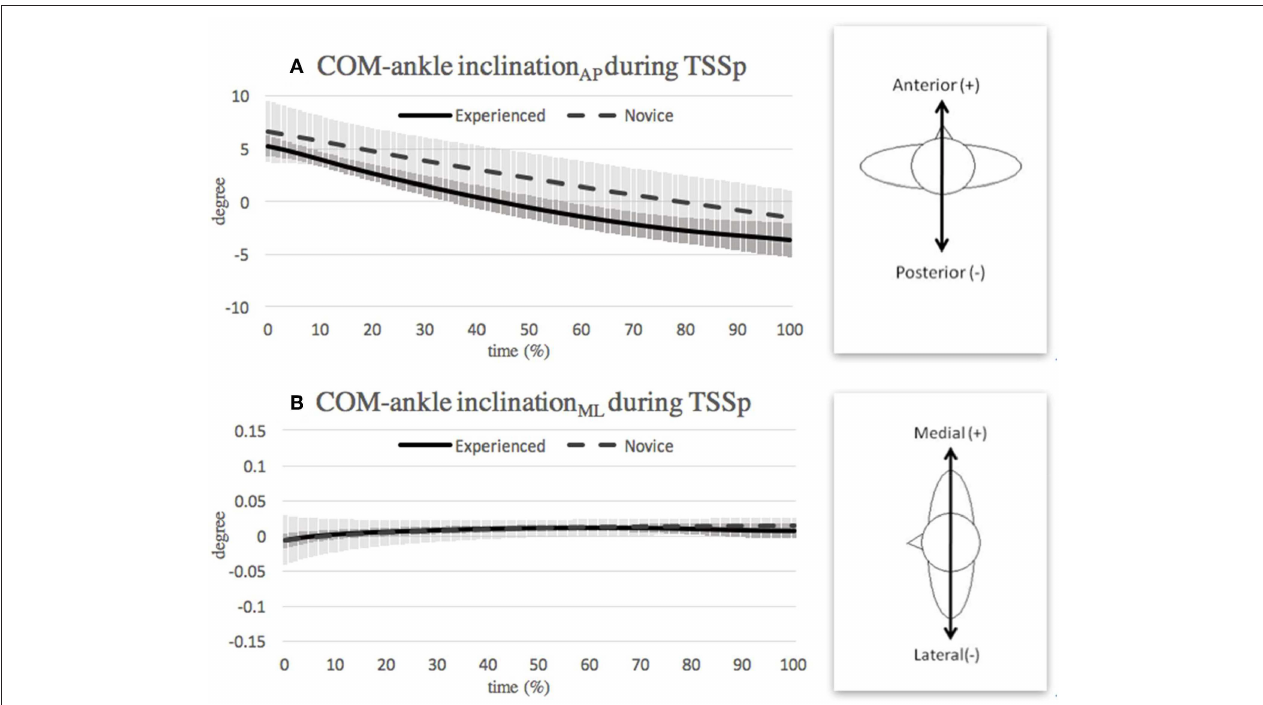
FIGURE 5 | Mean and SD of COM-ankle inclination angle in (A) anterior-posterior direction and (B) medial-lateral direction during turning with single-leg support in pre-swing (TSSp) phase. Note that the curves show the average value obtained over the three highest-scoring trials of each individual in the respective